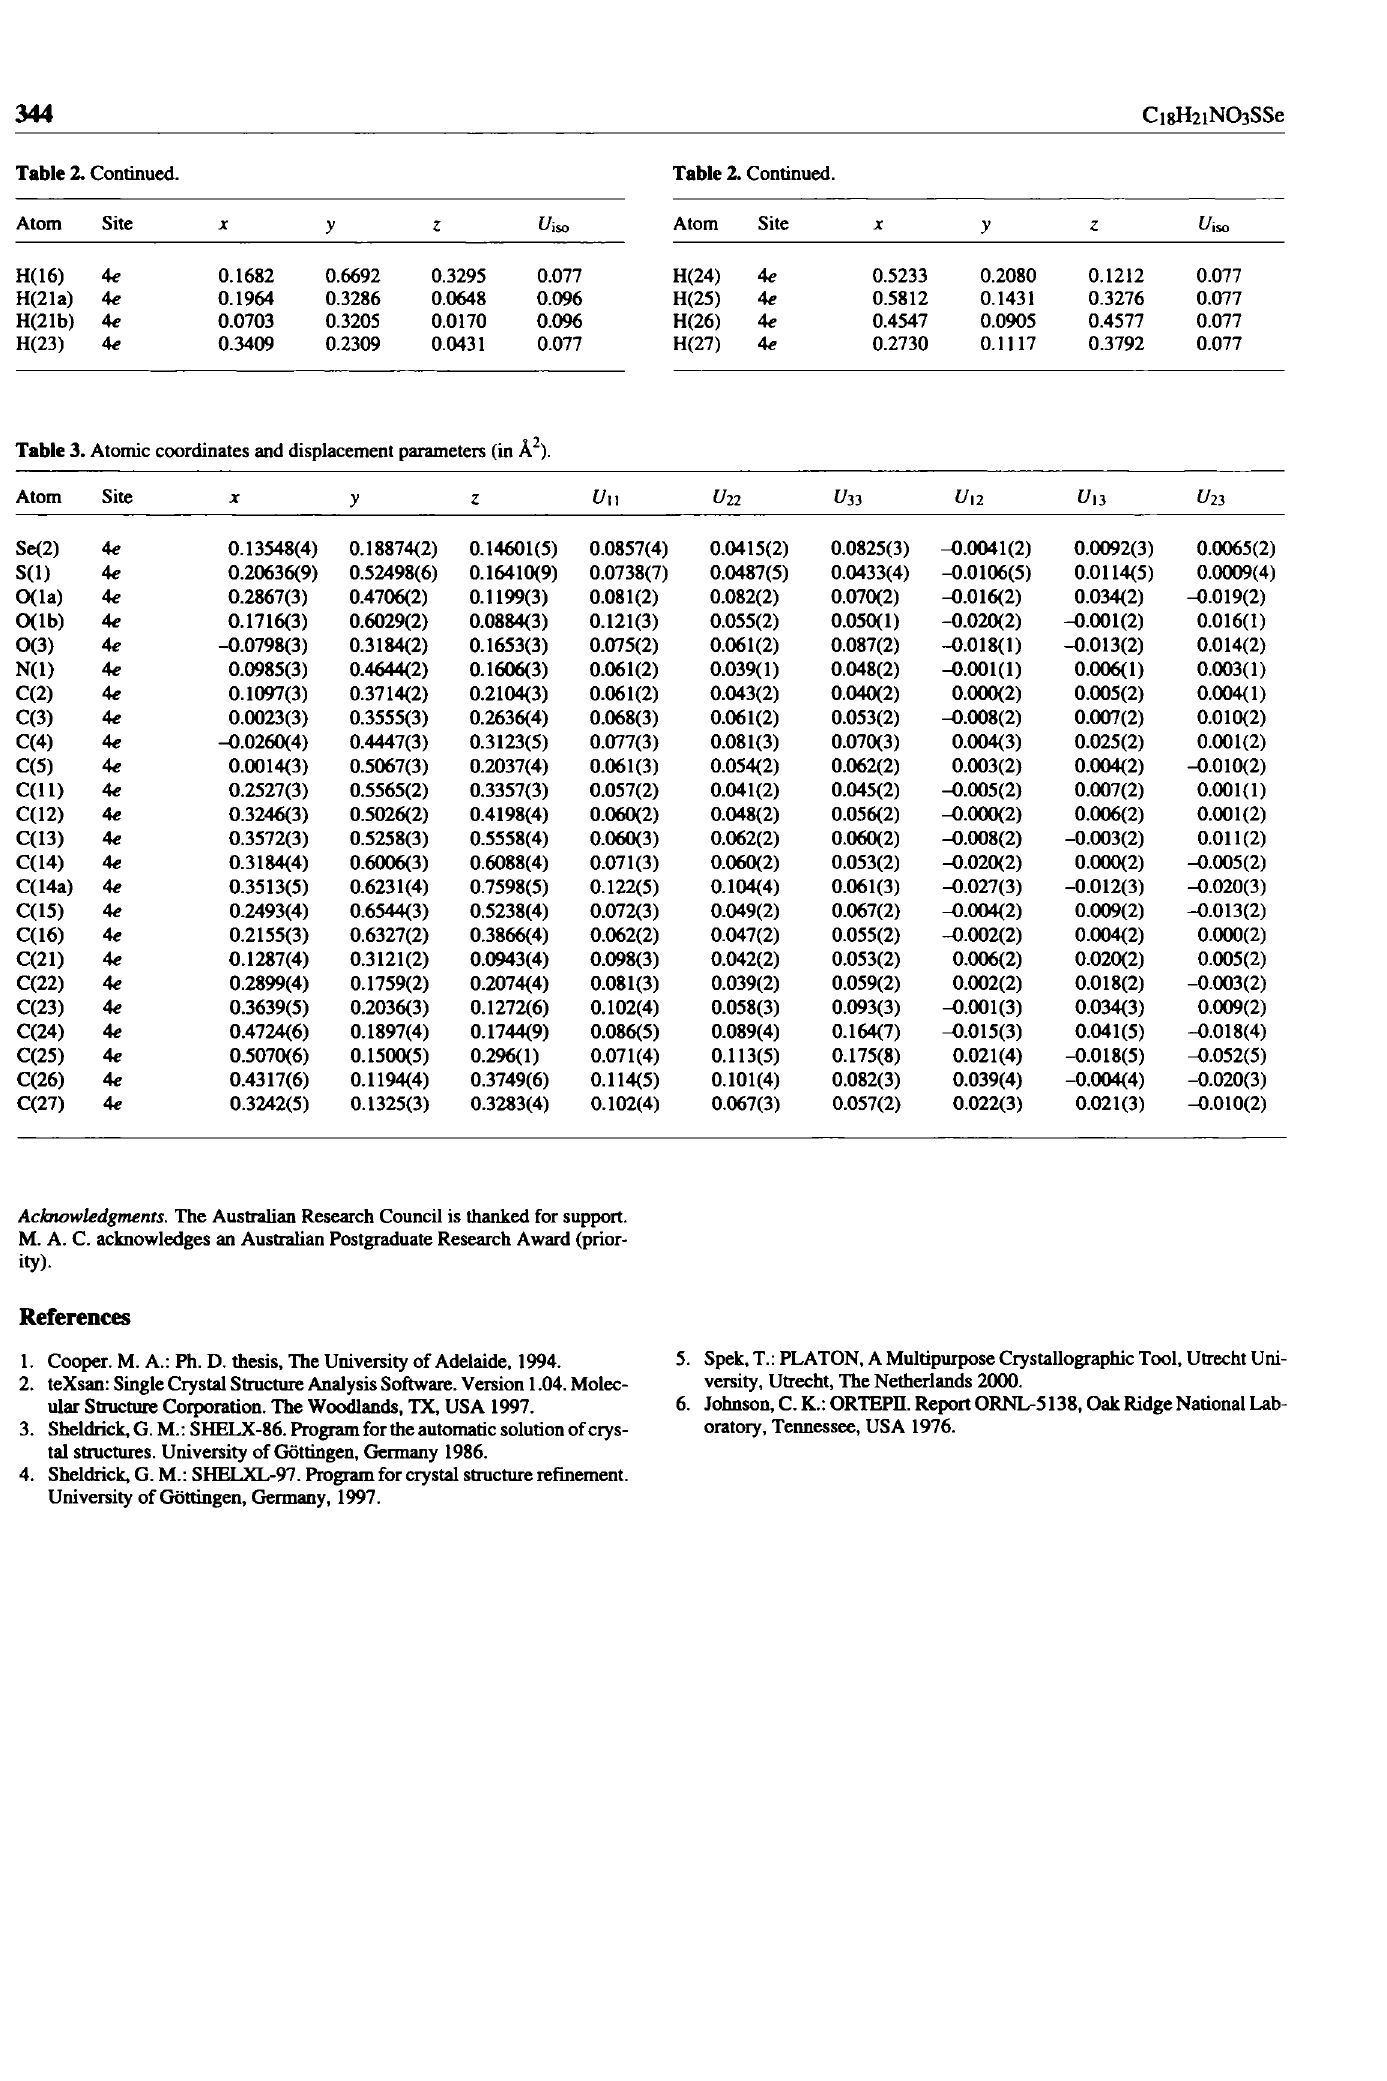
Table 3. Atomic coordinates and displacement parameters (in À 2